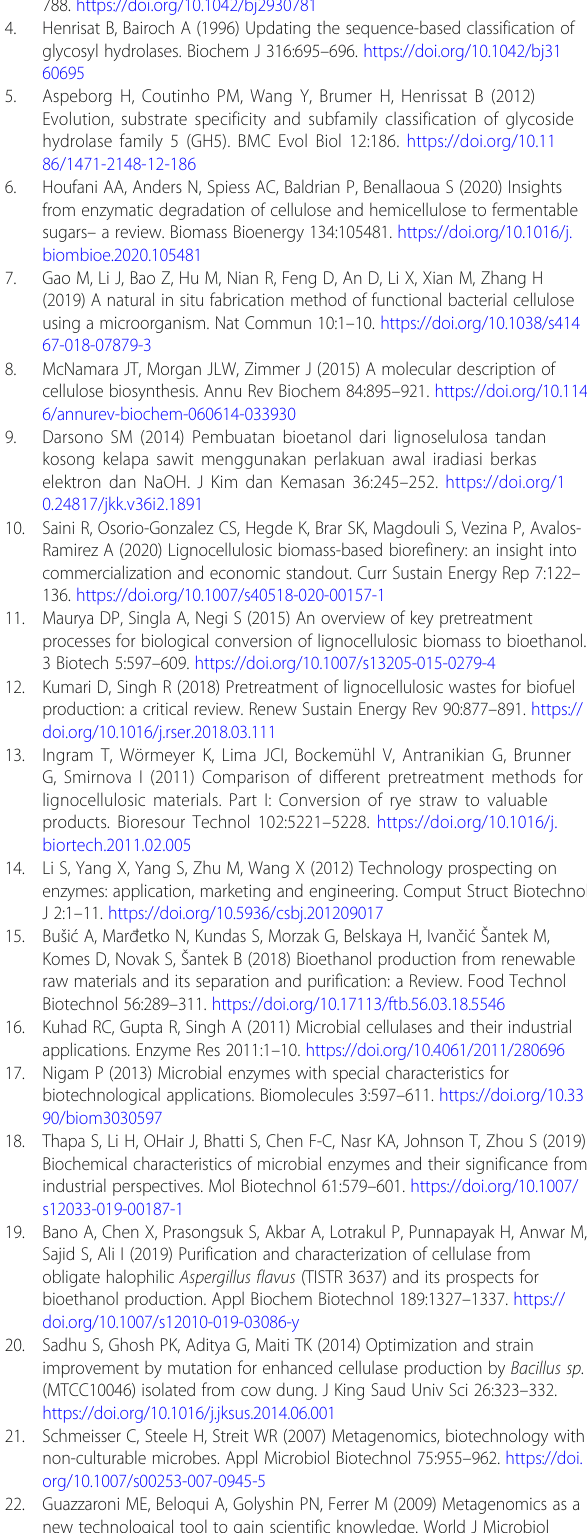
Abbreviations GH5: Glycoside hydrolase family 5; CAZy: Carbohydrate-Active